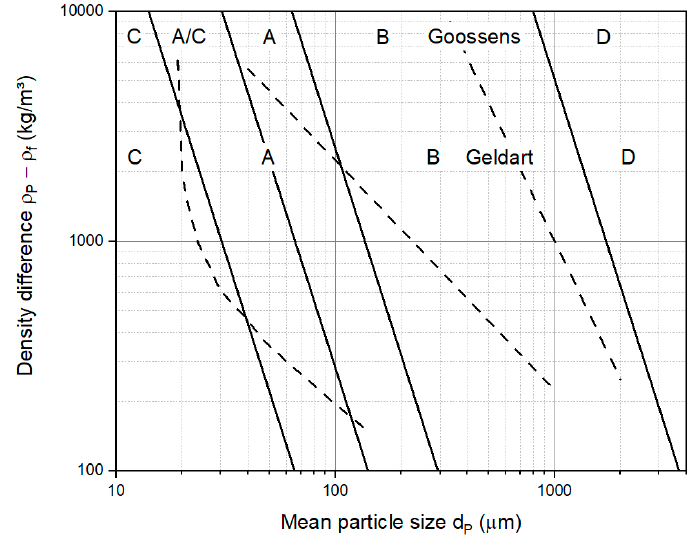
Figure 2. General classification diagram for fluidized particles in ambient conditions and air, including boundaries based on Geldart [35], dashed lines and Goossens [36], solid lines. These boundaries are derived from the transition points between viscous (laminar) and kinetic (turbulent) flow effects for the situation of entrainment or minimum fluidization and the corresponding correlations between the Reynolds number, Re, and the